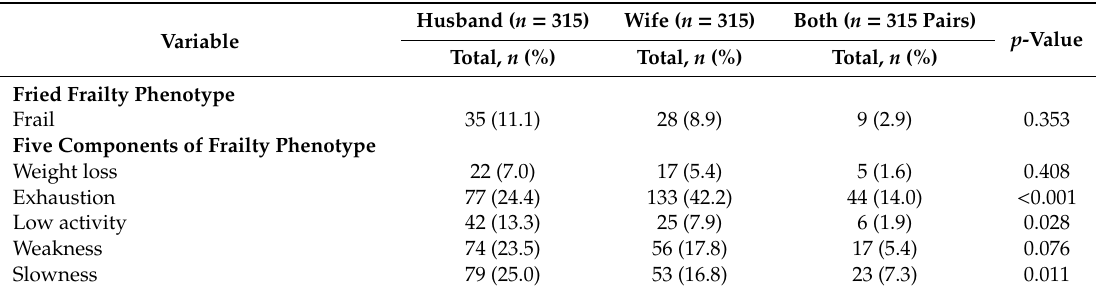
Table 2. Proportion of Fried frailty phenotype by